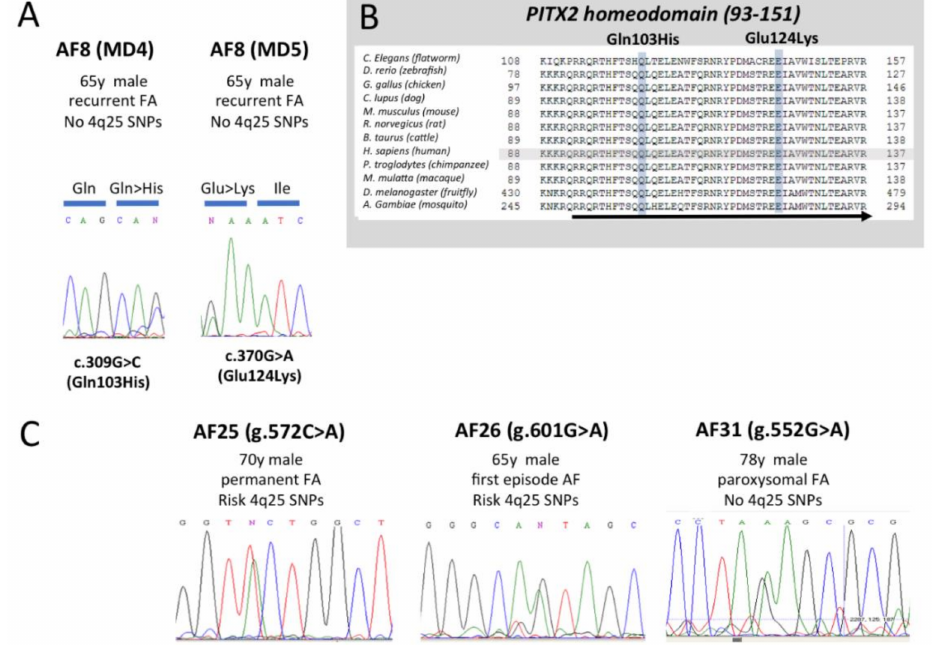
Figure 1. Pitx2 mutations in atrial fibrillation patients. Panel ( A ). Representative chromatograms of c.309G>C (Q1103H) and c.370G>A (Glu124Lys) mutations in the PITX2 homeodomain identified in a AF patient. Panel ( B ). Comparative alignment of the PITX2 homeodomain region illustrating the conserved amino acid position of these identified mutations in different species. Panel ( C